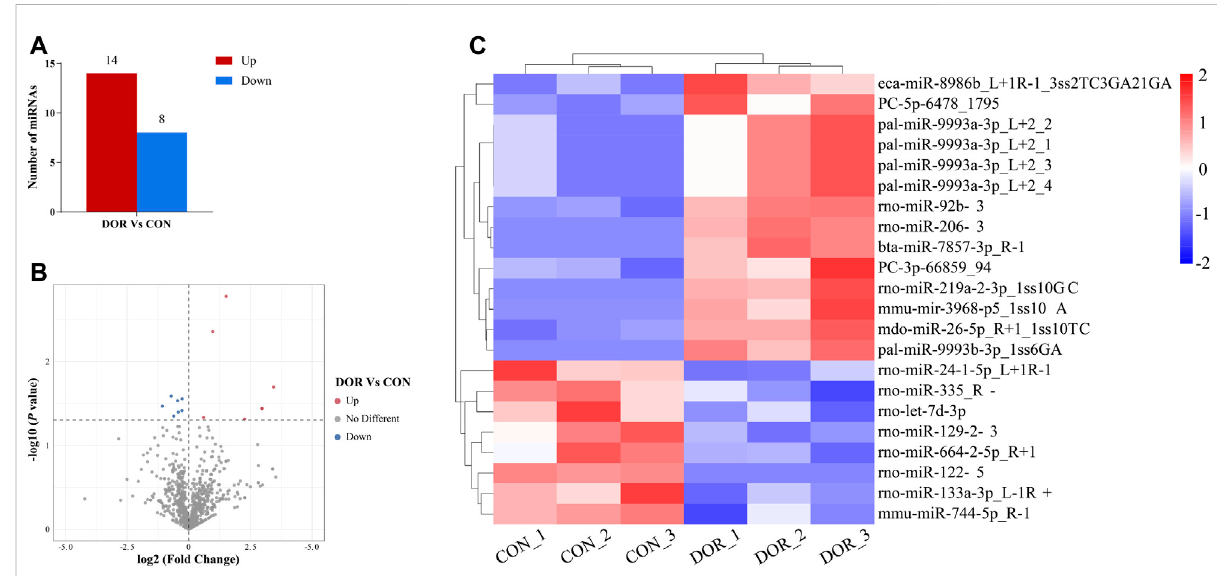
AnalysisofDEmiRNAsintheCONandDORgroups. (A) ThenumberofupregulatedanddownregulatedDEmiRNAswasidenti fi ed( p < 0.01). (B) Volcano plot showing DE miRNAs ( p < 0.05). (C) Heatmap showing the relative expression of DE miRNAs ( p < 0.05, log2 (FC) ≥ 1 or < = − 1; red: high expression; blue: low expression). CON, control group; DOR, diminished ovarian reserve; DE miRNAs, differentially expressed miRNAs.